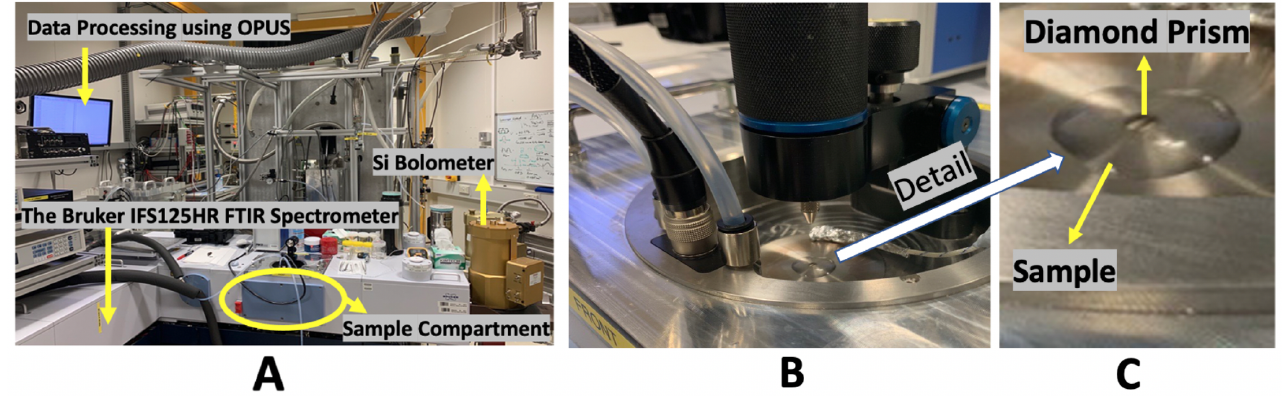
Figure 3. ( A ) The ATR apparatus setup available at the THz/Far-IR Beamline at the Australian Synchrotron in Melbourne, Australia, the ATR is equipped with a Bruker IFS125HR spectrometer with a scanning length of 5 m ( B ) Measuring the reflectance spectra of a sample using the ATR apparatus, which has a diamond prism ( n = 2.40), and a fixed 45 ◦ incoming beam angle that is located below the central window. The sample is placed above this window. ( C ) The close snapshot of the ATR apparatus showing the diamond prism. As noted in Figure 1, the incident radiation is totally reflected at the sample/diamond interface in the true ATR mode , and in Partial reflection/partial transmission mode, the beam is partially absorbed by the transition through the sample and partially reflected and reverted to a travelling wave at the return to the sample/diamond interface.